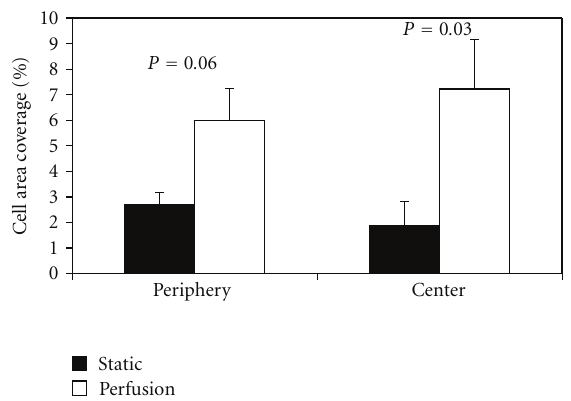
Figure 8: Cell/matrix area coverage is increased in three- dimensional sca ff olds when exposed to perfusion flow for 14 days. Cell/matrix area coverage was calculated as a percentage of cell and matrix area within pore spaces to total pore space area. Periphery is the mean value of the 8 peripheral regions.